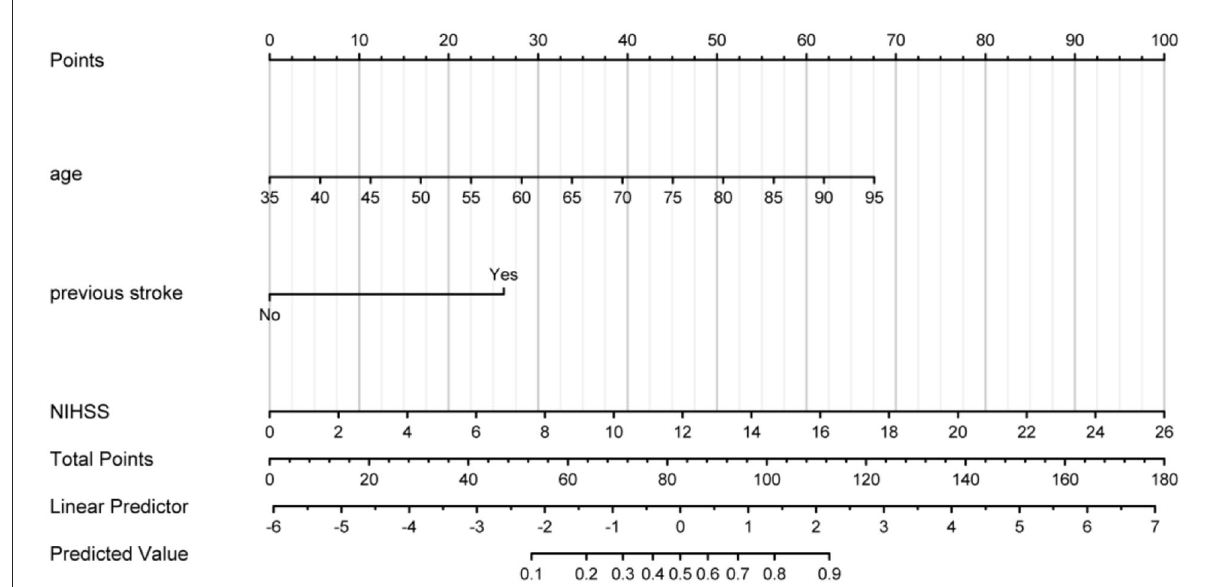
FIGURE2 Prognostic nomogram developed for AIS. The nomogram included age, previous stroke, and NIHSS. The nomogram and its algorithm used to predict the risk of poor prognosis in AIS are as follows. First, find the corresponding score on the points line at the top of each variable for patients with AIS; then add all the scores and find the corresponding point on the total points. Finally, find the predicted probability corresponding to the patient on the predicted value line. AIS, acute ischemic stroke; NIHSS, the National Institute of Health Stroke Scale score.